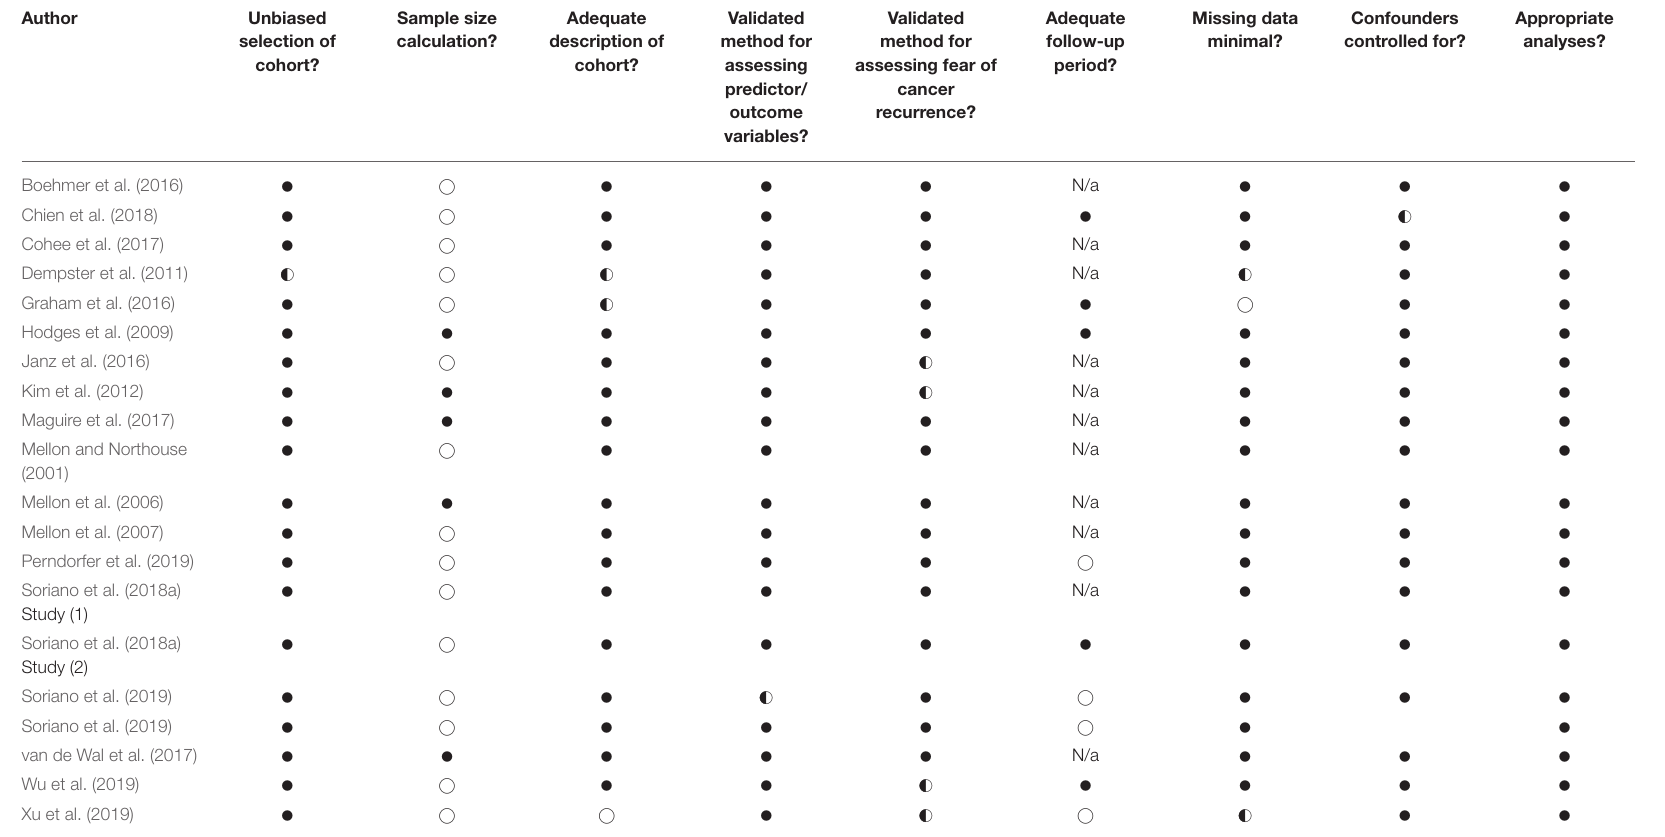
TABLE 3 | Assessment of risk of